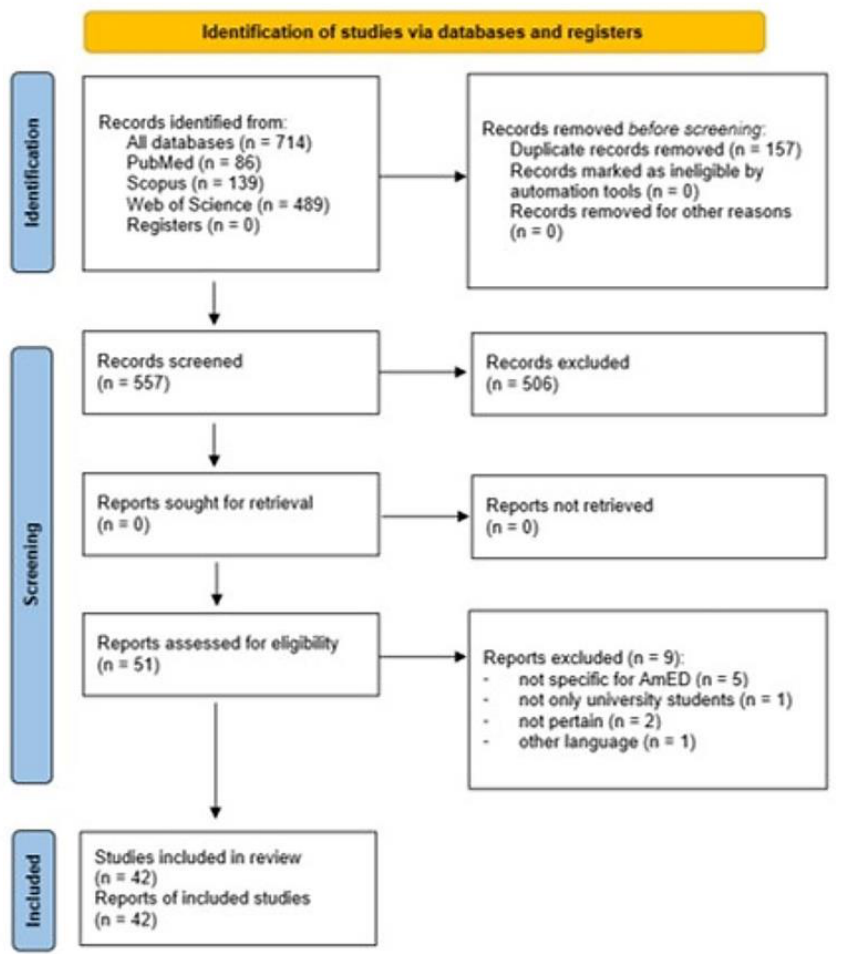
Figure 1. PRISMA flowchart of search strategy.